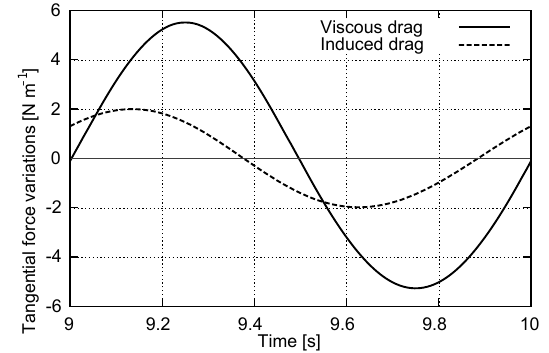
Figure 5. Comparison of viscous drag and induced drag during os- cillations of a cambered airfoil parallel to the inflow at 1Hz. The effect of camber is included as proposed in Eq. (20). The mean drag has been